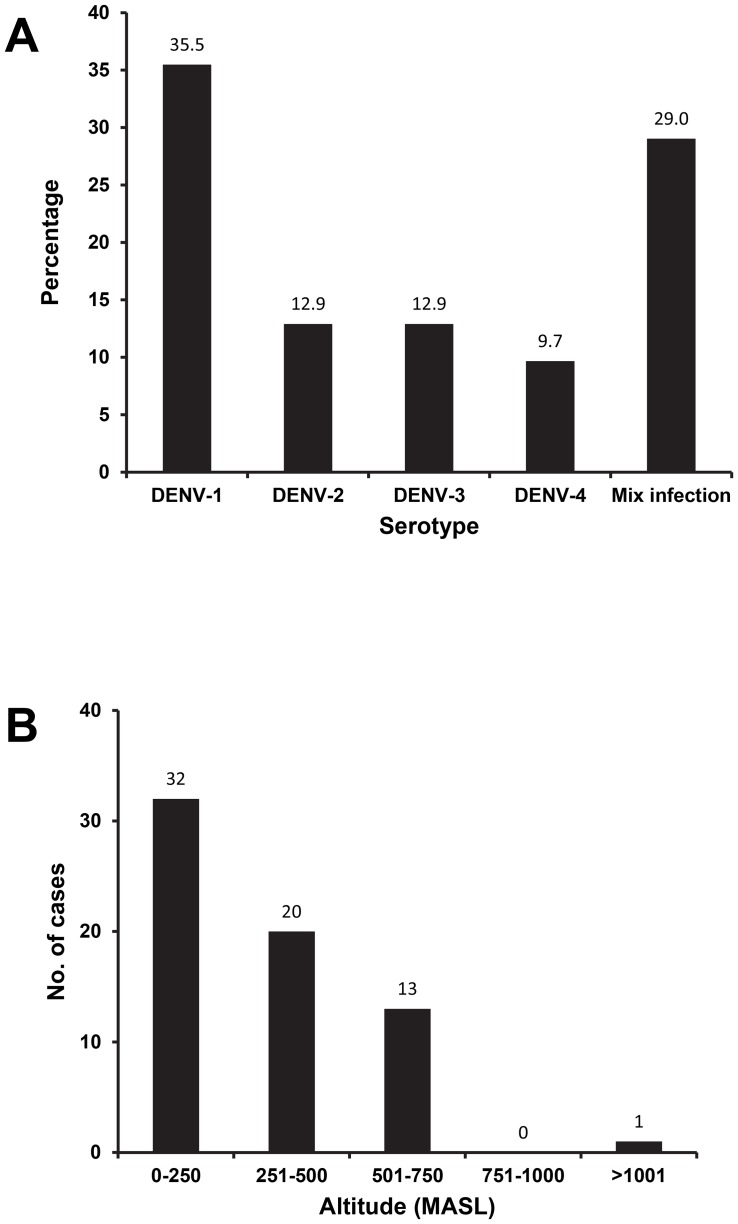
Dengue virus serotype distribution (A) and the altitude of dengue cases (B).Serotypes were determined using both conventional RT-PCR and real-time RT-PCR as described in the Method section. The altitudes of the locations where the cases occurred were recorded using altimeter.